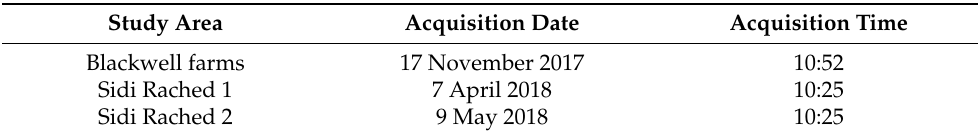
Table 5. Landsat-8 acquisition